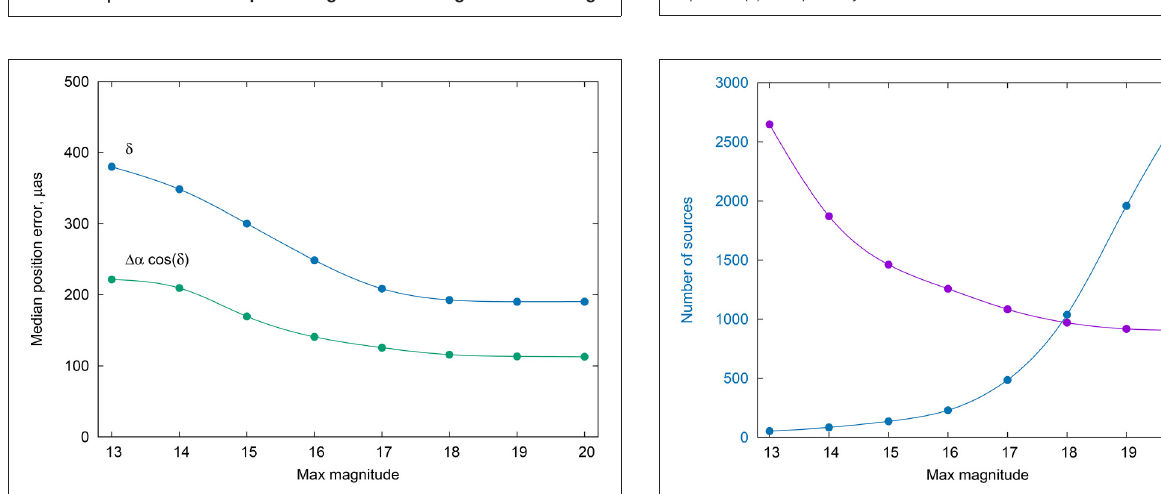
FIGURE 6 | Expected Gaia position error according to de Bruijne et al. (2014) (points). Solid line corresponds to the approximation function Equation (4) multiplied by 0.743.